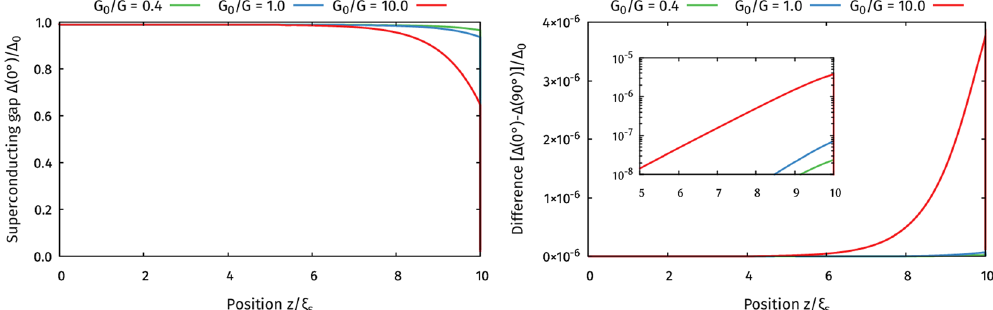
Figure 11. Plot of the superconducting gap Δ as a function of position inside the superconductor in the S/F/N/HM setup. The left plot shows the result for a 0° misalignment between the magnetizations of the F and HM, which is a measure of the proximity effect in the system. The right plot shows the difference between the results for 0° and 90° misalignment, which is a measure of the spin-valve effect. The inset shows how this spin- valve effect decays on a logarithmic scale. As indicated in the legends, we repeated the calculations for various interface conductances G 0